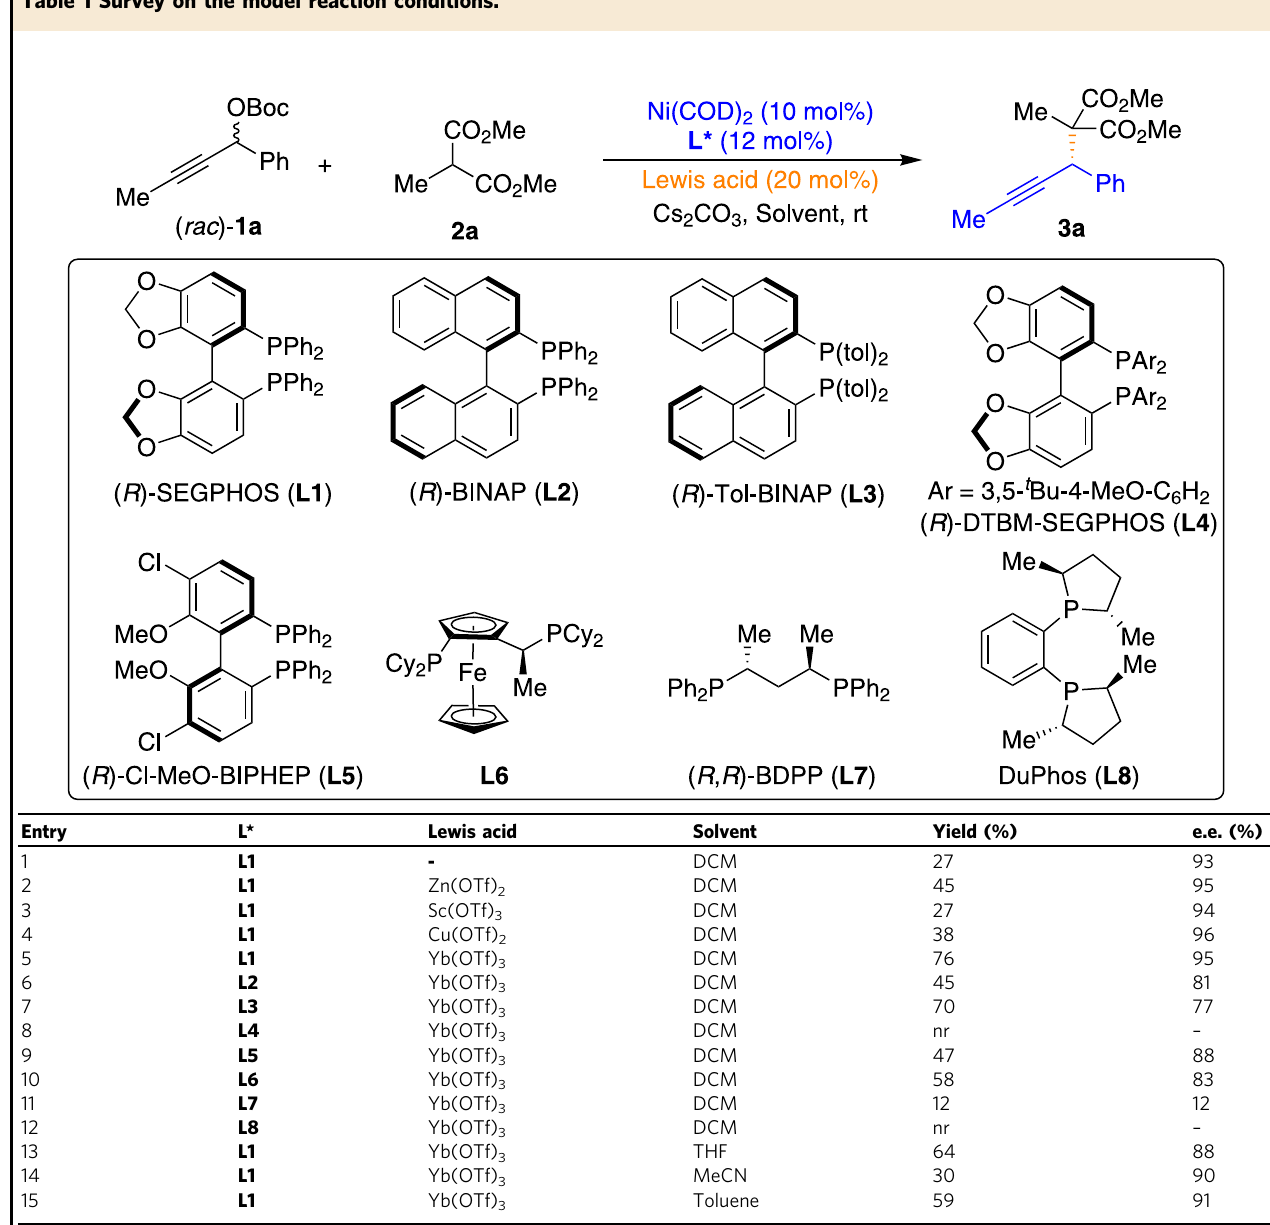
Table 1 Survey on the model reaction